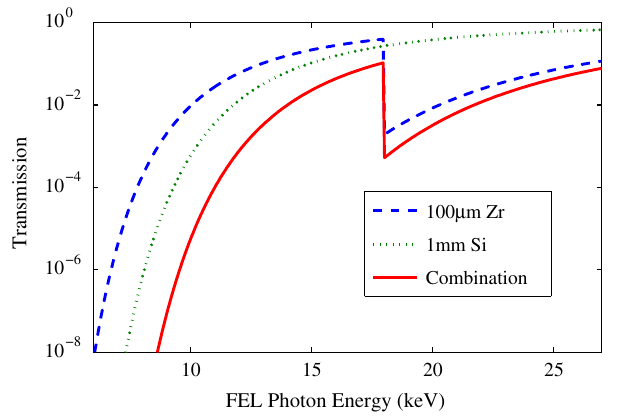
FIG. 5. Transmission for the zirconium filter as a function of photon energy. The filter is made of 100 (cid:1) m of zirconium (dashed blue) and 1 mm of silicon (dotted green), with the combined transmission given in solid red. The zirconium K edge manifests as a sharp drop in transmission at 18 keV.